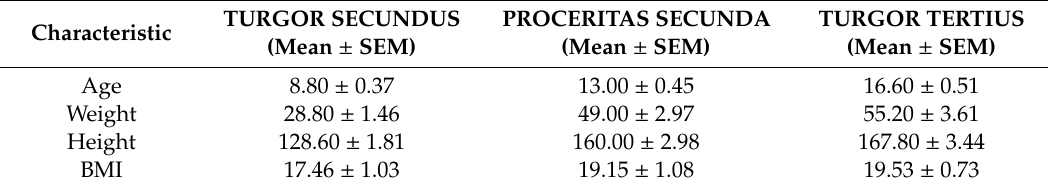
Table 1. Characteristics of participants recruited to conduct the present study expressed as mean fold change ±